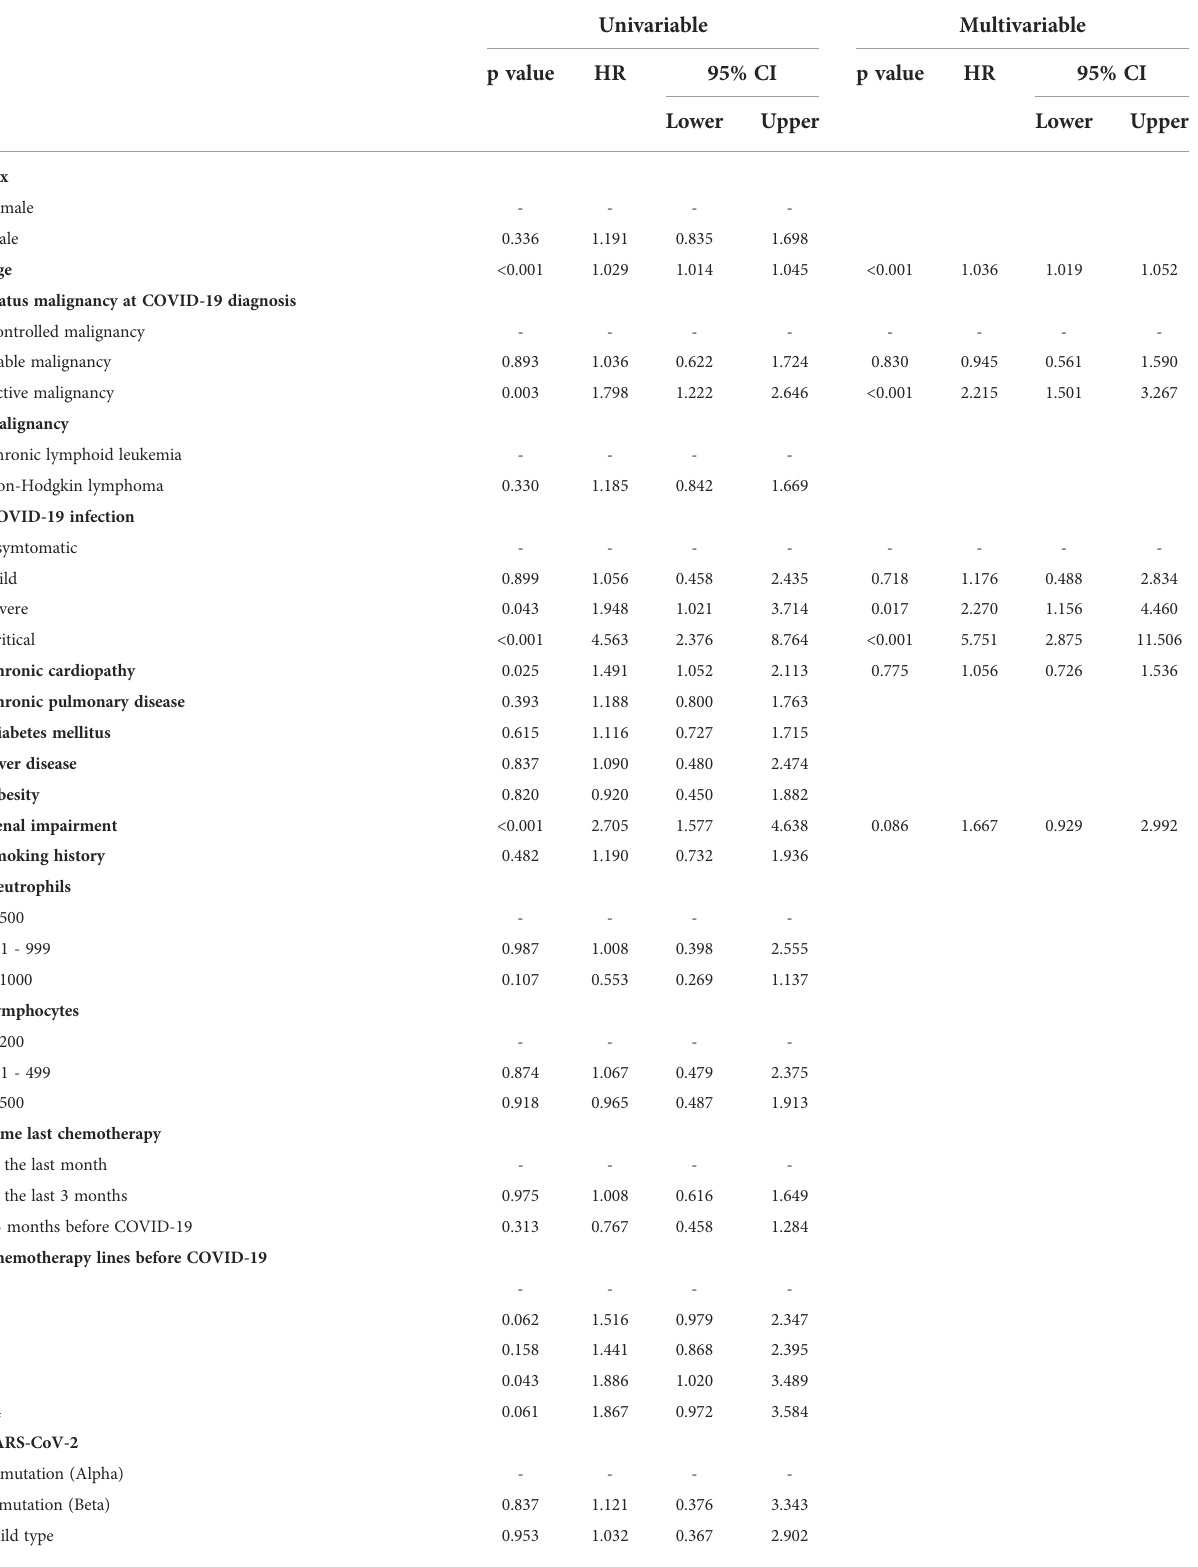
TABLE 4A Univariable and multivariable analysis of predictors of mortality in the entire